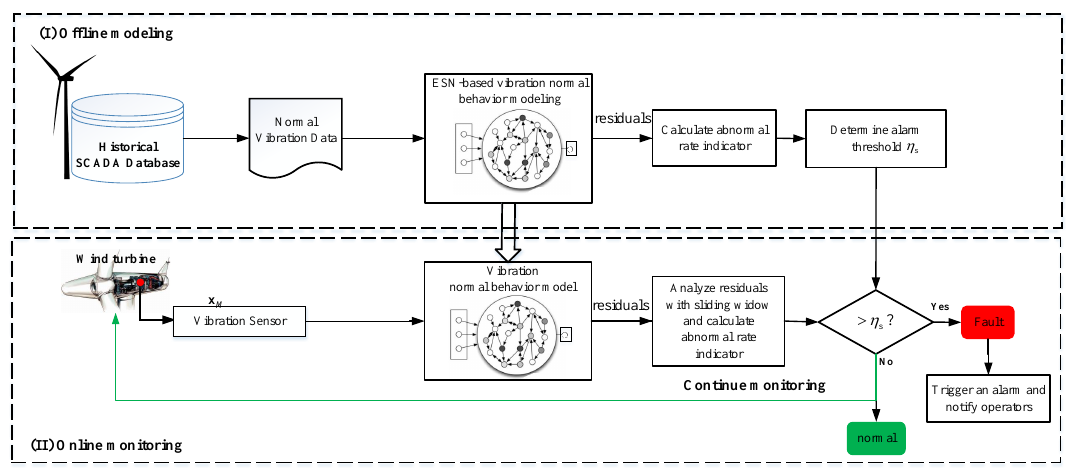
Figure 3. Flowchart of the proposed gearbox vibration monitoring